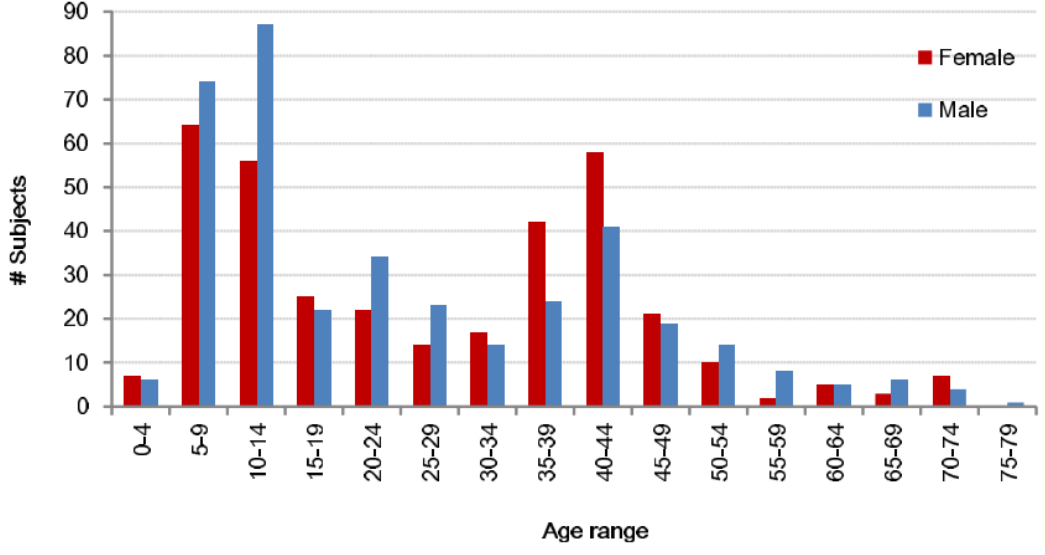
Figure 1. Gender and age distribution of the database.